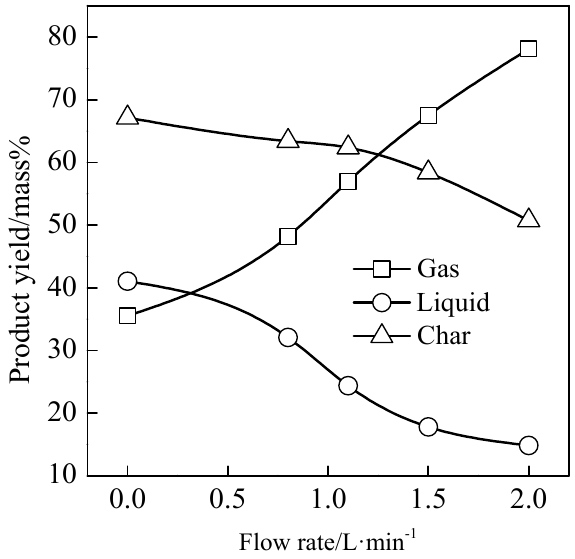
Figure 5. The effect of the CO 2 flow rate on the product yield at 900 ◦ C. The effect of the CO 2 flow rate on the direct gasification characteristics of lignite at 900 ◦ C is given in Table 4. As can be seen, when the CO 2 flow rate increased from 0 L min − 1 to 2.0 L min − 1 , the total gas yield raised from 18.86 to 40.09 mol kg − 1 . The combustible gas yields of H 2 , CO, CH 4, and C 2 H n under different CO 2 flow rates at 900 ◦ C are presented